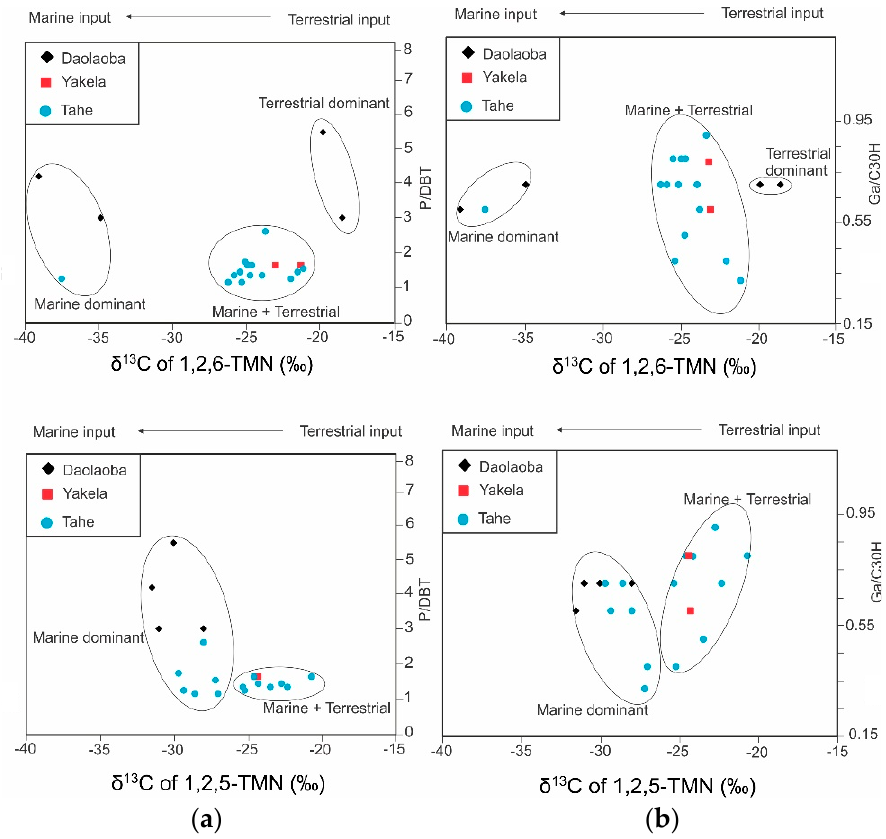
Figure 6. Plots of δ 13 C of 1,2,6-TMN and 1,2,5-TMN versus ( a ) P/DBT and ( b ) Ga/C 30 H ratios of 20 selected oils from Tarim Basin. Similar captions are used in Figures 6 and 7.